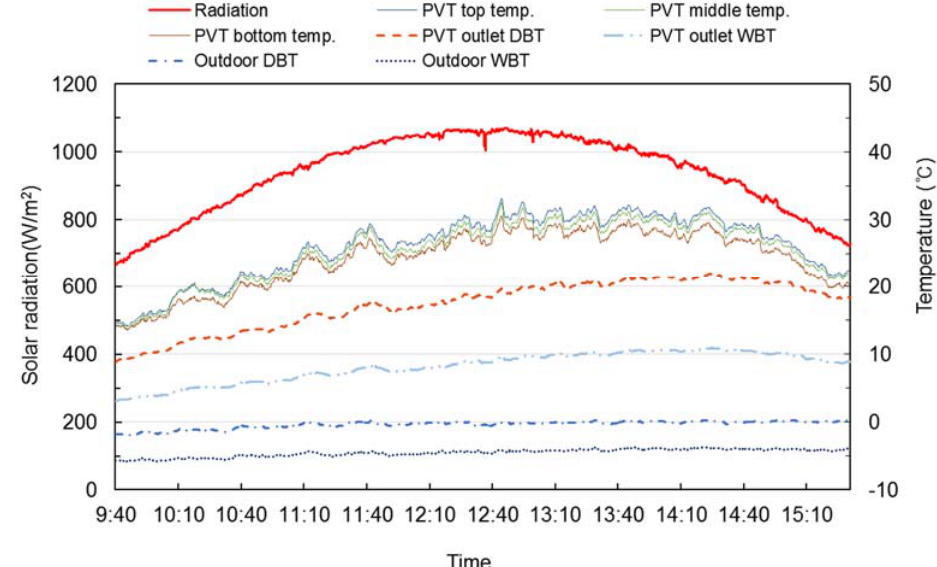
Figure 9. Temperature characteristics of the PVT system with the HRV during the heating season.